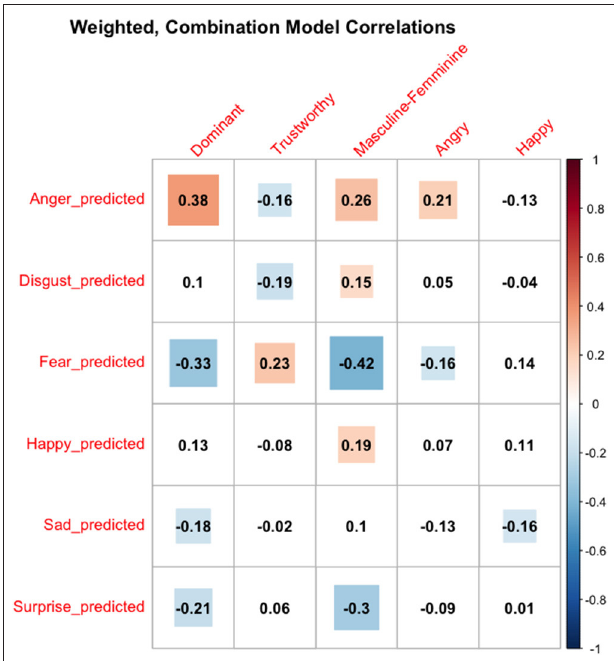
FIGURE 3 | Correlations between weighted combination model predictions and human impressions. Machine-derived output is on the Y-axis, whereas human ratings are on the X-axis. Colored cells are significant. Hot colors are significant positive correlations and cool colors are significant negative